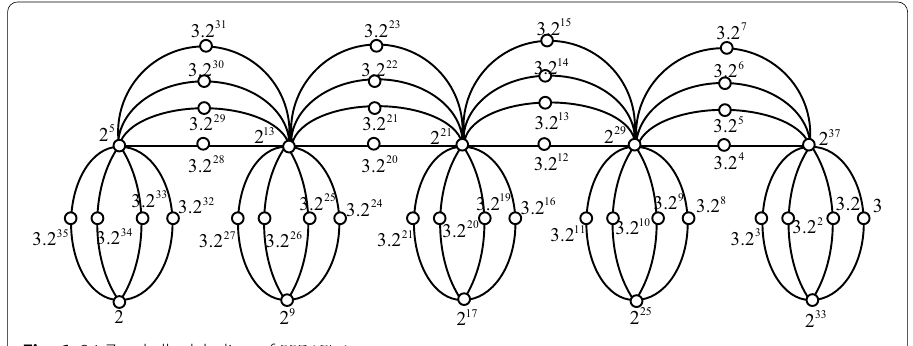
Fig. 6 24-Zumkeller labeling of SSD ( CL 5 )